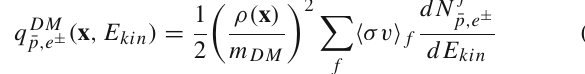
tivity from LZ7.2T. The lower parts show the dark matter annihilation cross sections (cid:4) σv (cid:5) where the curves are the 95% CL upper limits from the AMS-02 anti-proton data [25] and the Fermi-LAT γ -ray data (dwarf spheroidal galaxies) [24]. The bino, wino and higgsino samples repre- sent bino-like, wino-like and higgsino-like LSP,